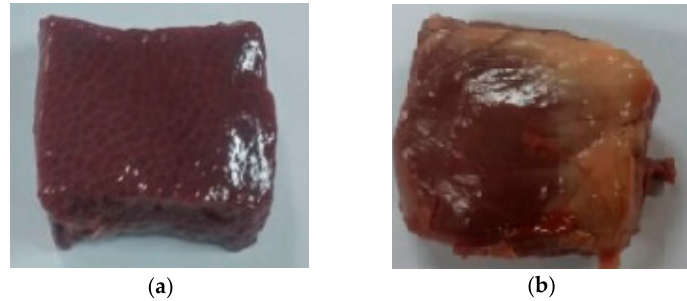
Figure 3. The specimens tested in this work; ( a ) porcine liver; ( b ) porcine heart.